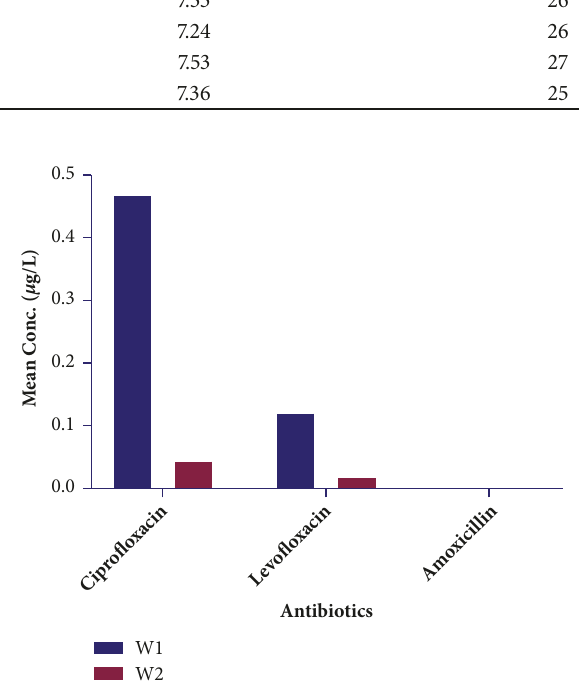
Figure 2: Presence of antibiotics in the raw and finished water at the Al-Wihda plant. The mean value of antibiotics (ciprofloxacin, levofloxacin, and amoxicillin) in the raw and finished water in Al- Wihda plant was illustrated, where the blue columns refer to the concentration of antibiotics in the raw water (W1) and red columns refer to the levels in the finished water (W3). There is no detectable amoxicillin seen, which is indicated by black